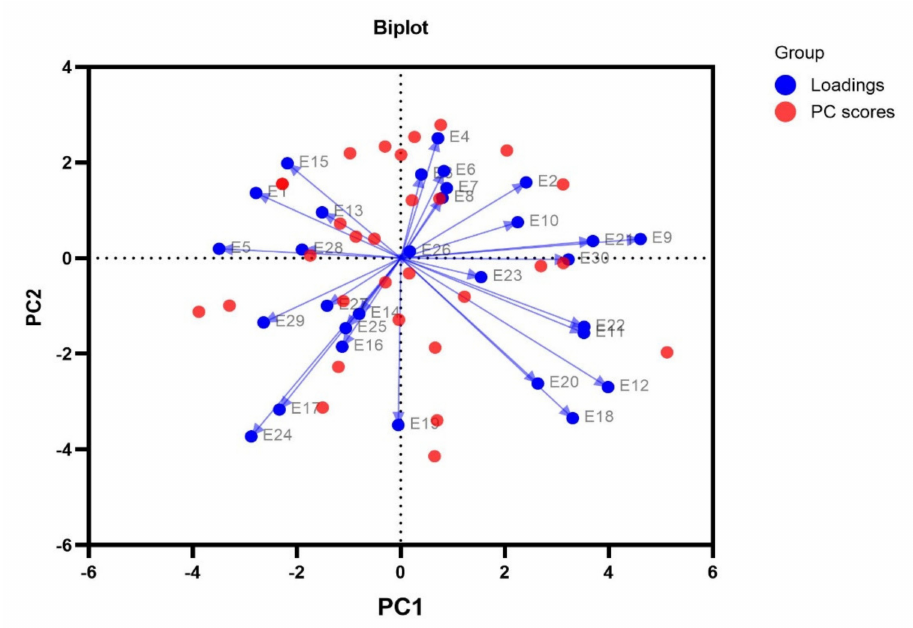
Figure 10. The biplot for PC1 and